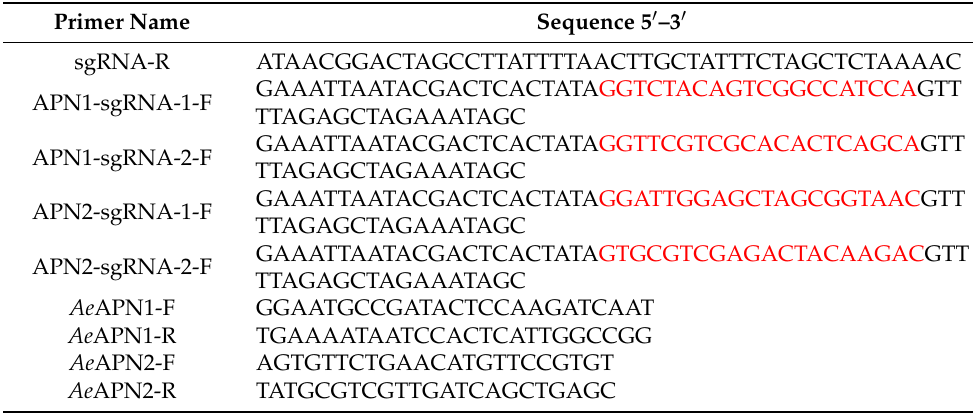
Table 1. List of DNA oligo primers used in this